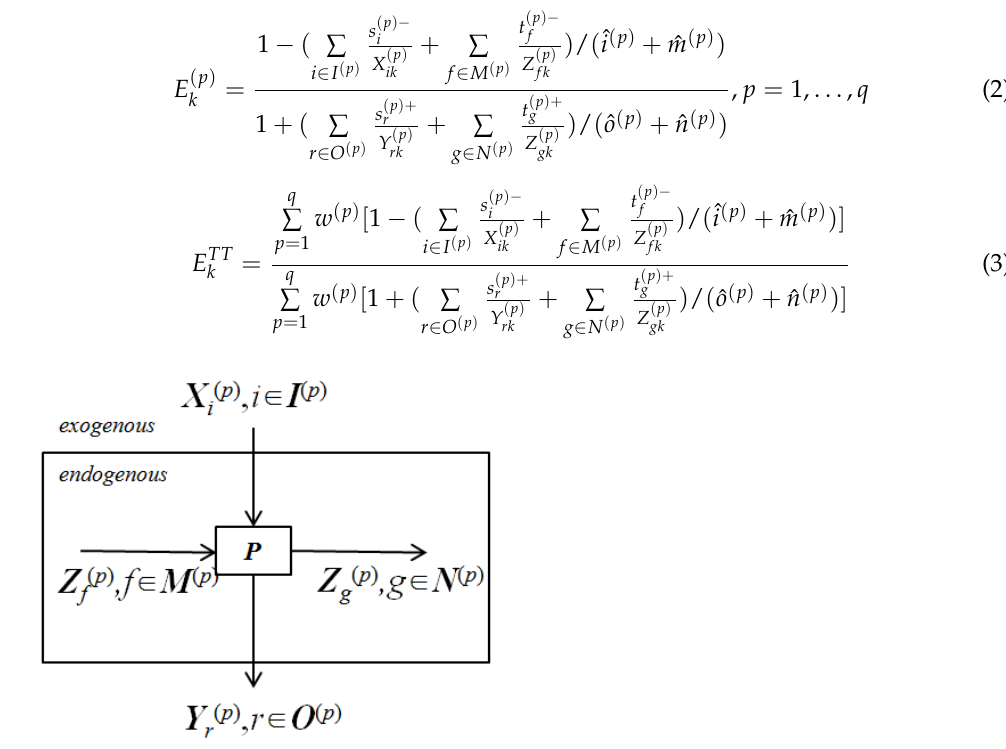
Figure 2. The structure of a general network system.